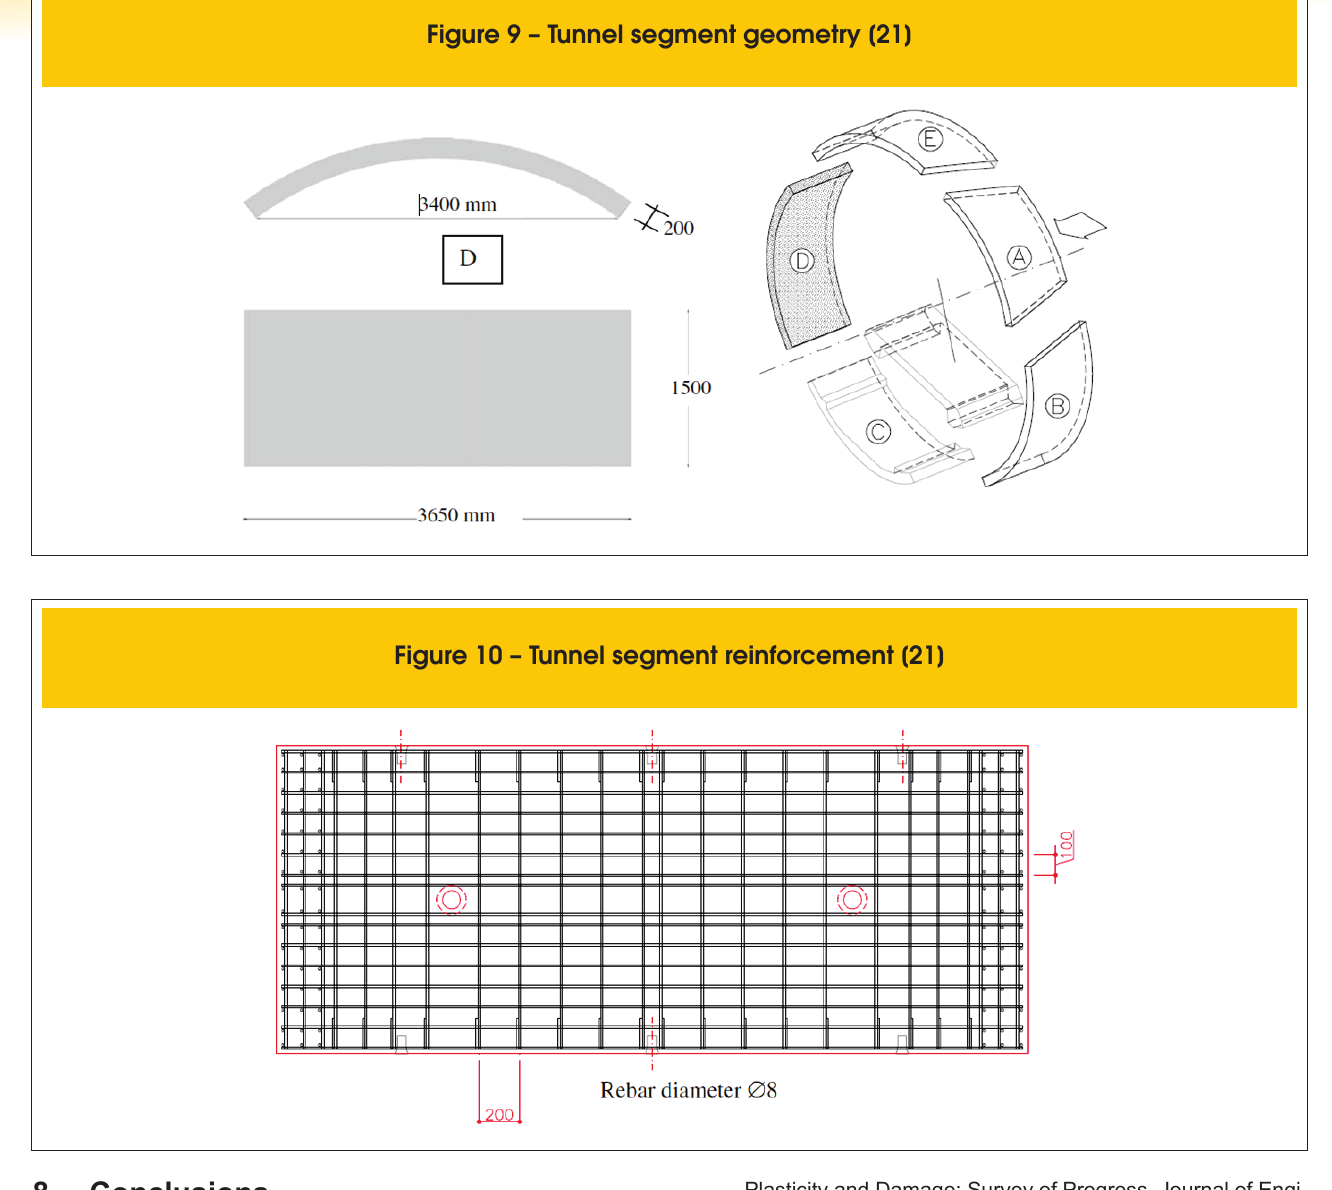
Figure 9 – Tunnel segment geometry [21]